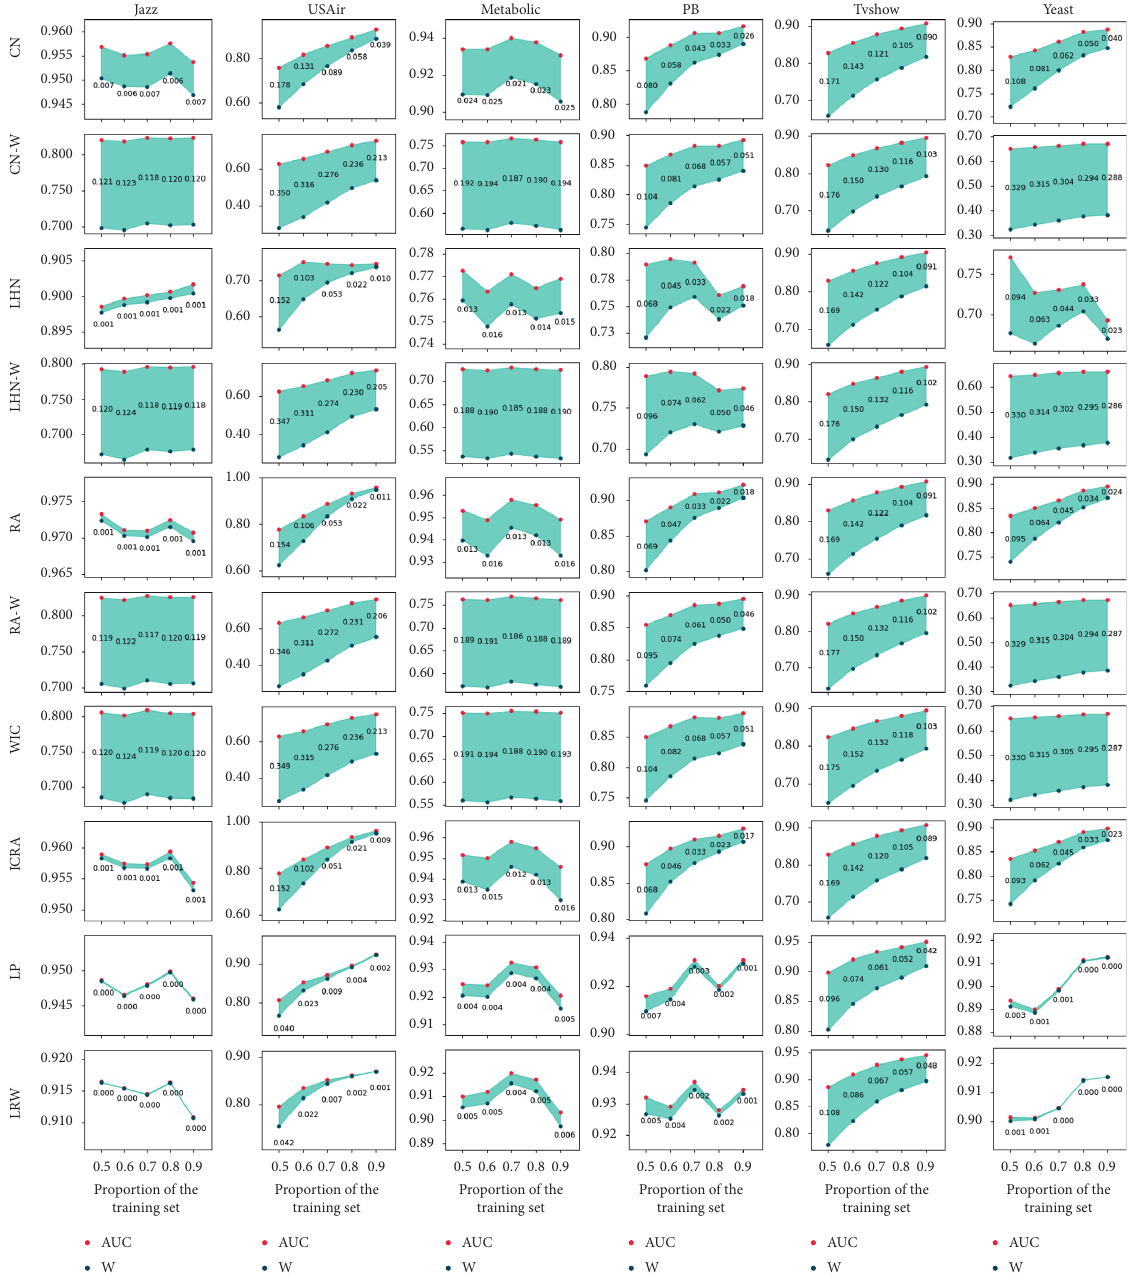
Figure 12: Performance of each predictor in the six networks under different proportions of the training